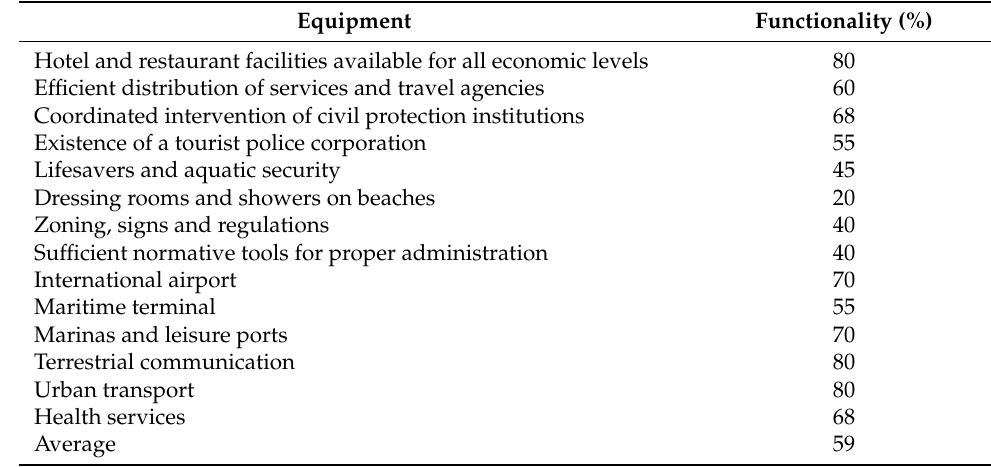
Table A7. Functionality of facilities in Mazatlan